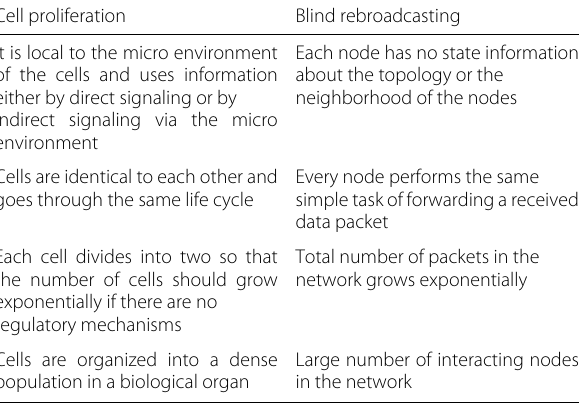
Table 3 Comparison of cell proliferation with